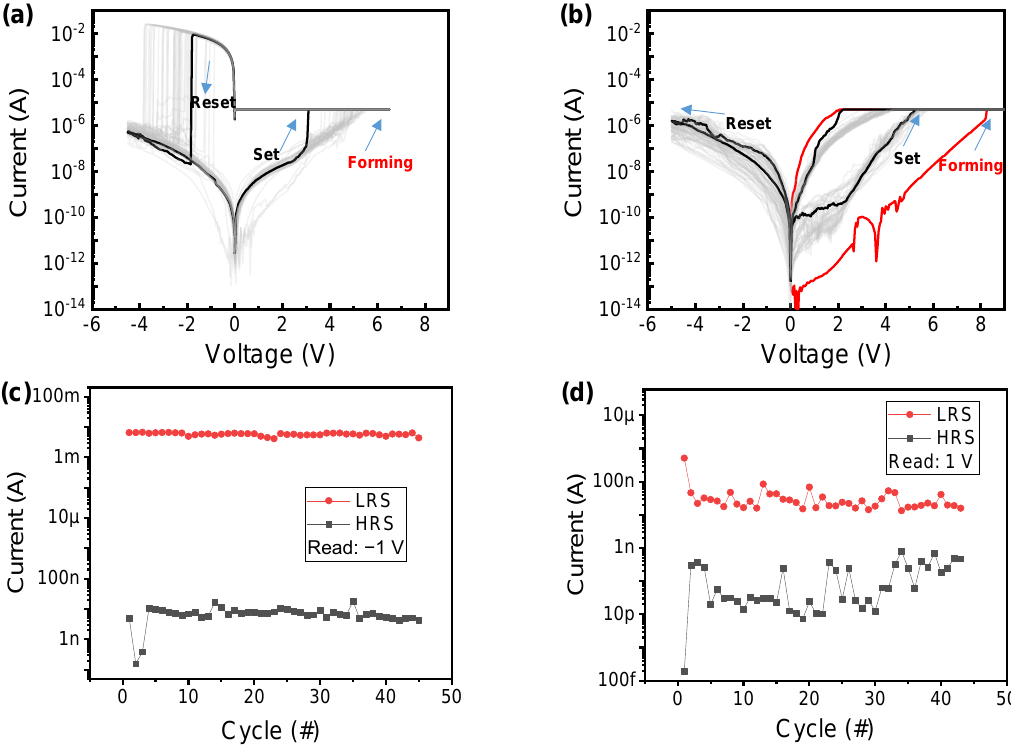
Figure 2. I–V characteristics of the ( a ) Ni / HfO 2 / SiO 2 / Si device and ( b ) Ni / HfO 2 / Si 3 N 4 / SiO 2 / Si device Figure 2. I – V characteristics of the ( a ) Ni/HfO 2 /SiO 2 /Si device and ( b ) Ni/HfO 2 /Si 3 N 4 /SiO 2 /Si device including forming, set, and reset processes; cycling data of I–V characteristics of ( c ) Ni / HfO 2 / SiO 2 / Si including forming, set, and reset processes; cycling data of I – V characteristics of ( c ) Ni/HfO 2 /SiO 2 /Si device and ( d ) Ni / HfO 2 / Si 3 N 4 / SiO 2 / Si device and ( d ) Ni/HfO 2 /Si 3 N 4 /SiO 2 /Si device.